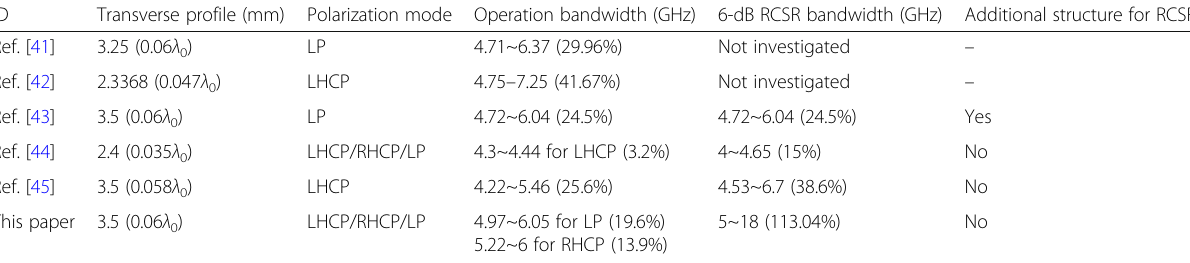
Table 1 Measured comparisons between the proposed design and former metasurface-based antenna